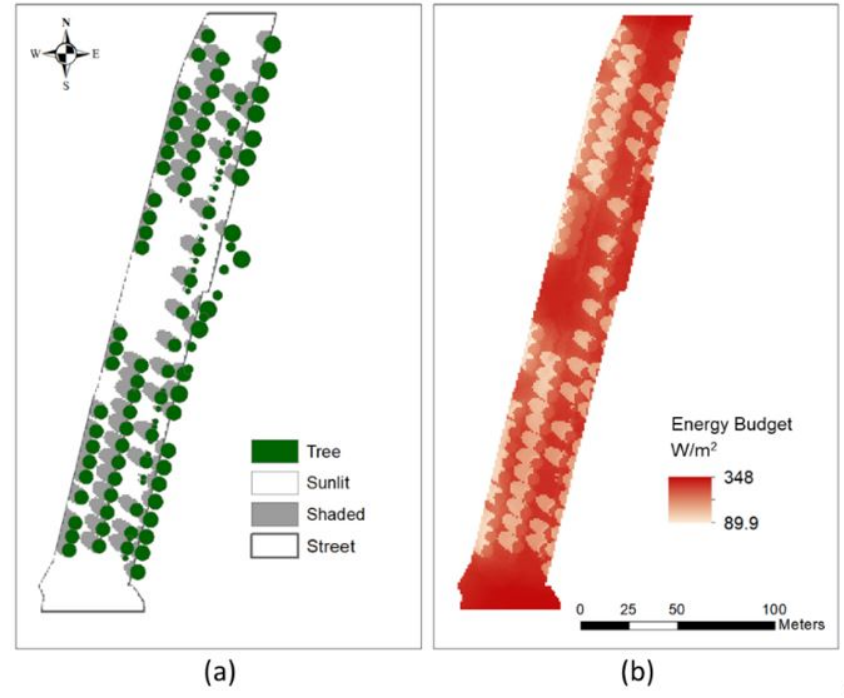
Figure 7. D-COMFA results for study site street at 10 a.m. 9 August 2016. ( a ) shade and sunlit areas and ( b ) EB